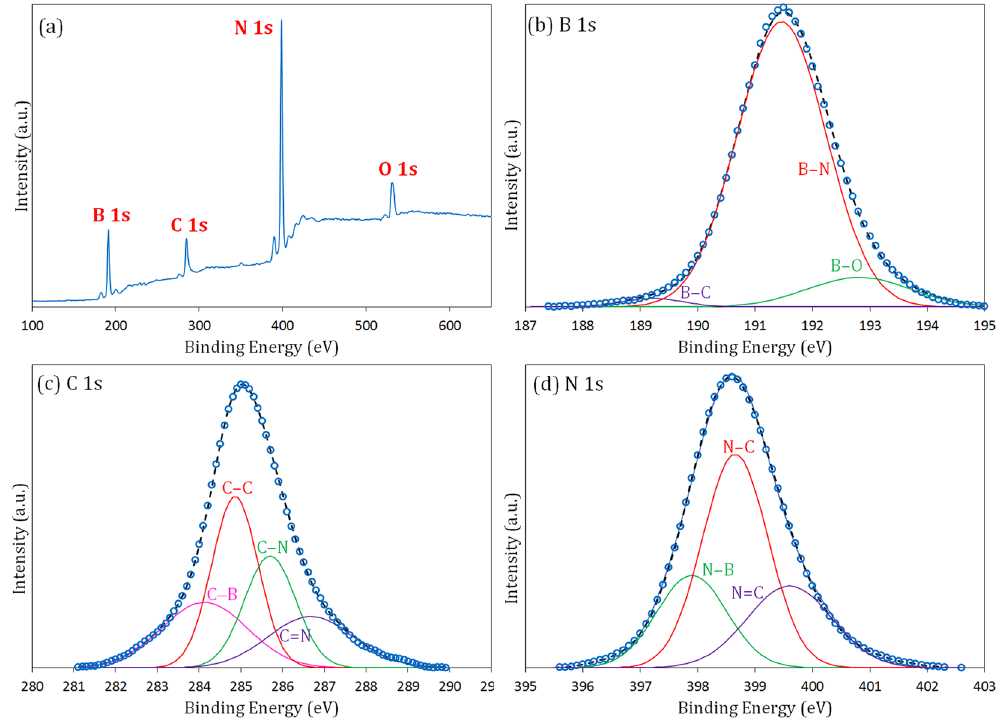
Figure 5. XPS data of sample M23 after combustion and the leaching treatment (open circles). Full survey scan ( a ) and high resolution spectra together with deconvoluted peaks for B 1 s ( b ), C 1 s ( c ) and N 1 s ( d ). The dashed lines are the resulting curves obtained by Gaussian fitting of the deconvoluted